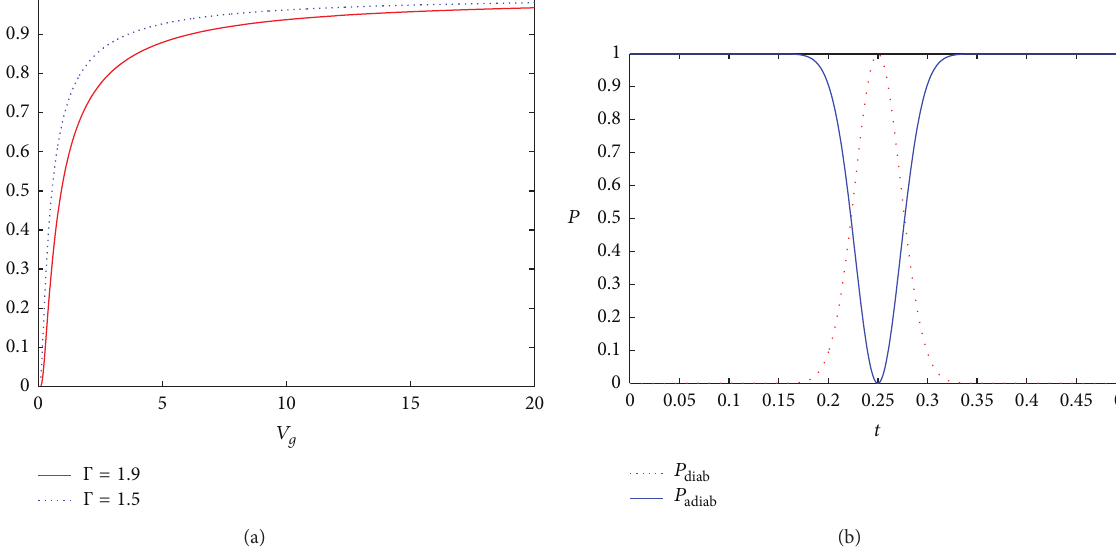
Figure 6: Plots of the LZ transition probability in the sudden limit expressed in (12). Figure 6(a) shows the LZ transition probability in function of the group velocity for different values of the noise factor Γ while Figure 6(b) shows the LZ transition probability in function of time in a diabatic (dot curve) and in adiabatic cases (solid